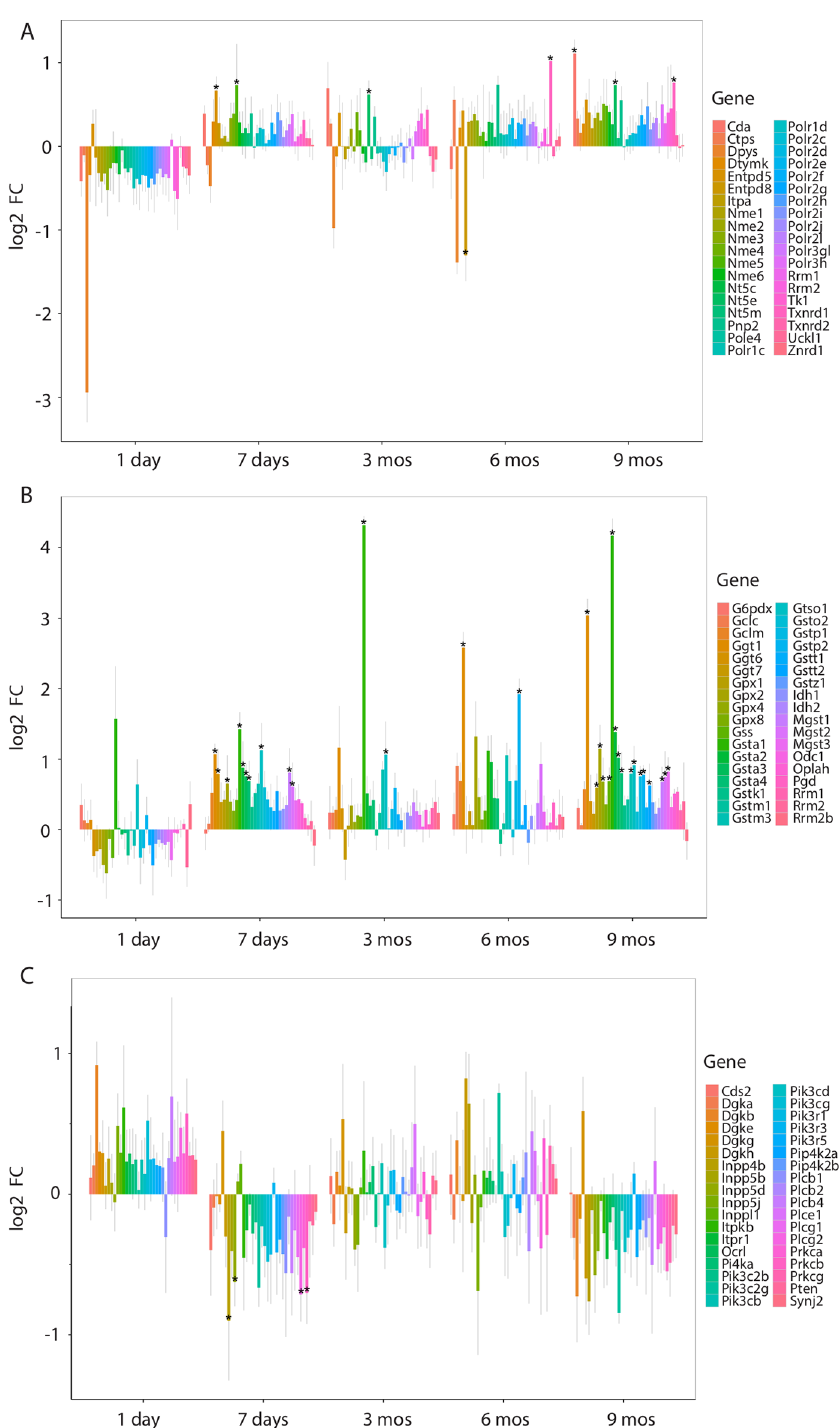
Fig 3. Behavior of influential genes in relevant metabolic pathways. Expression was summarized as base-2fold change (log2 FC). Influentialgenesdeterminedby GAGE using coreGeneSets, and are those member genesthat substantially contribute to the significance of the entire pathway [14]. (A) Pyrimidine metabolismwas initiallyenrichedfor downregulated genes, but later enrichedfor upregulatedgenesat 9 months of CS exposure. A gradualtransition from downregulationto upregulation is apparent,especiallyfor the gene Dpys . (B) Glutathionemetabolismwas the most consistently enriched KEGG pathway for